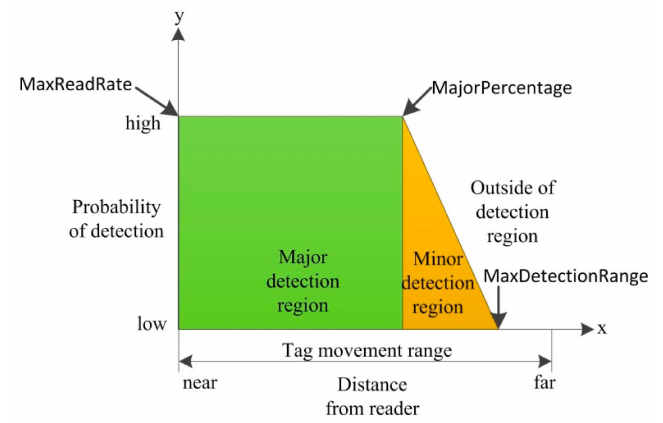
Figure 5. RFID tag-reader detection model.